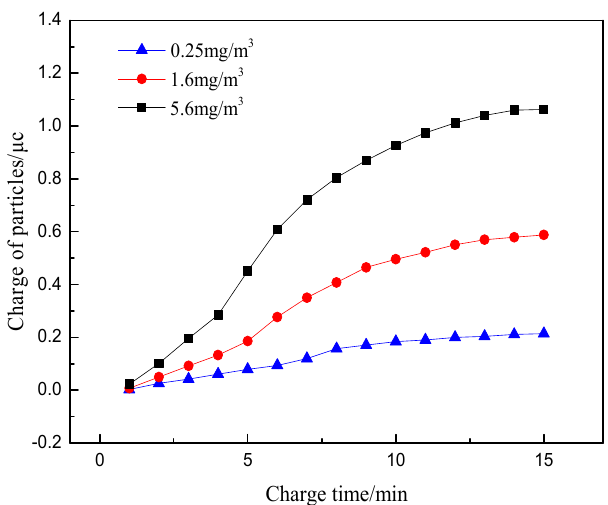
Figure 8. The relationship between the charge amount of particles and time at different